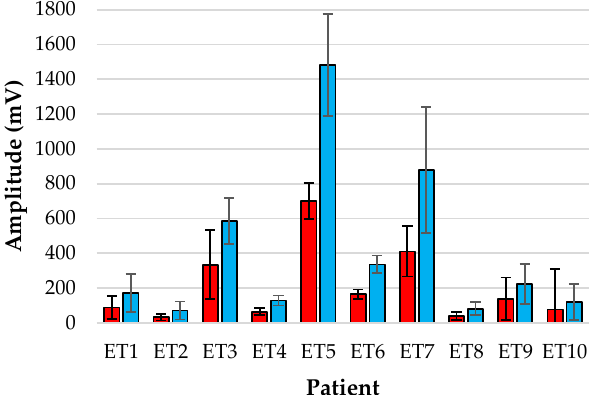
Figure 5. Amplitude analysis of normalised red (red) and infrared (blue) PPGs from the tracheal tube sensor for each patient over the monitoring